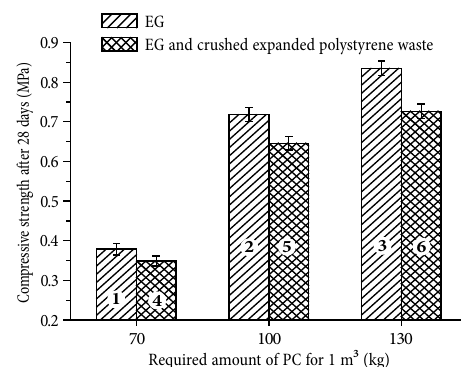
Required amount of PC for 1 m  Fig. 5. Influence of the amount of PC on compressive strength after 28 days of LWAC samples of 1÷6 compositions